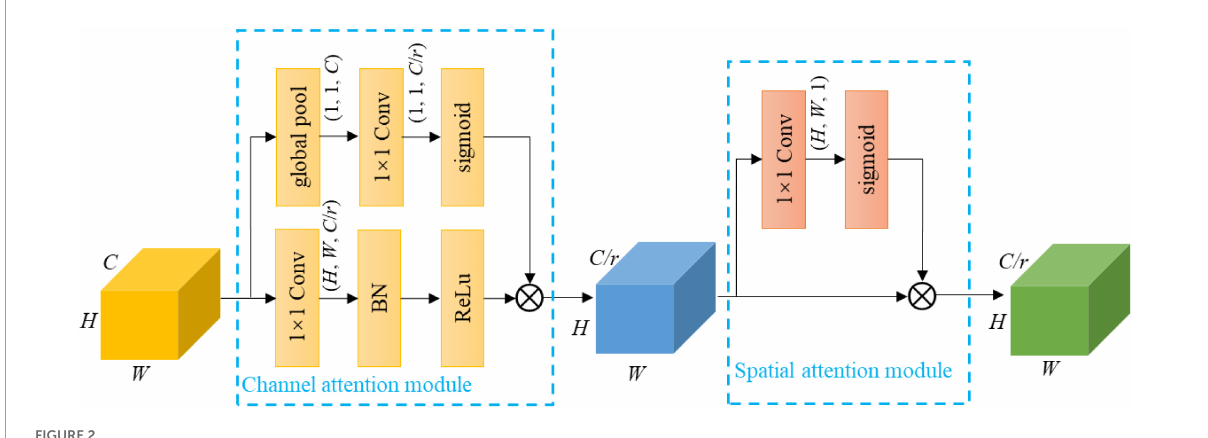
FIGURE2 Design details of CSAM. Note that Conv is convolutional operation, and BN is batch normalization; 1 × 1 represents the kernel size, H × W × C and H × W × C / r denote the tensor shape (height, width, and depth); the first N refers to channel-wise multiplication, and the second N is element-wise